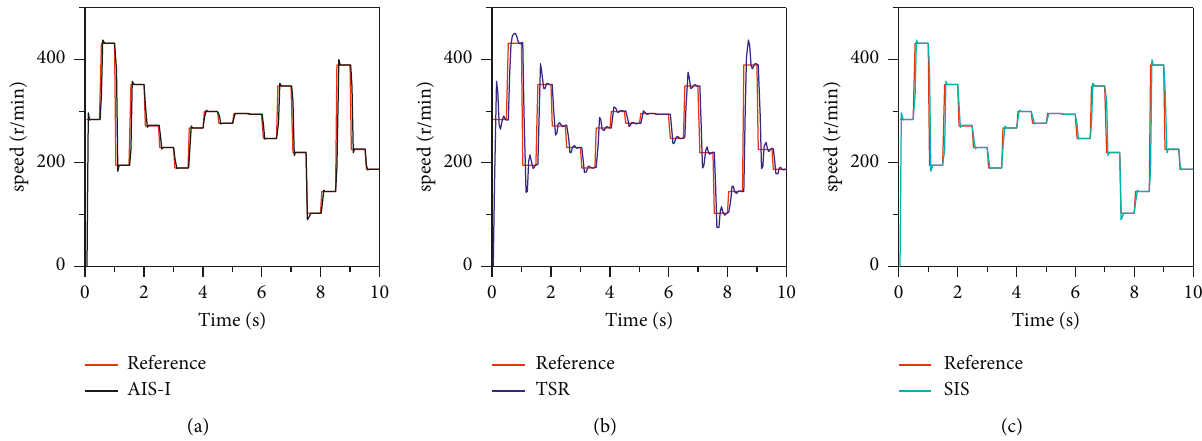
Figure 8: Simulated speed response: (a) speed response based on the AIS-I method, (b) speed response based on the TSR method, and (c) speed response based on the SIS method.